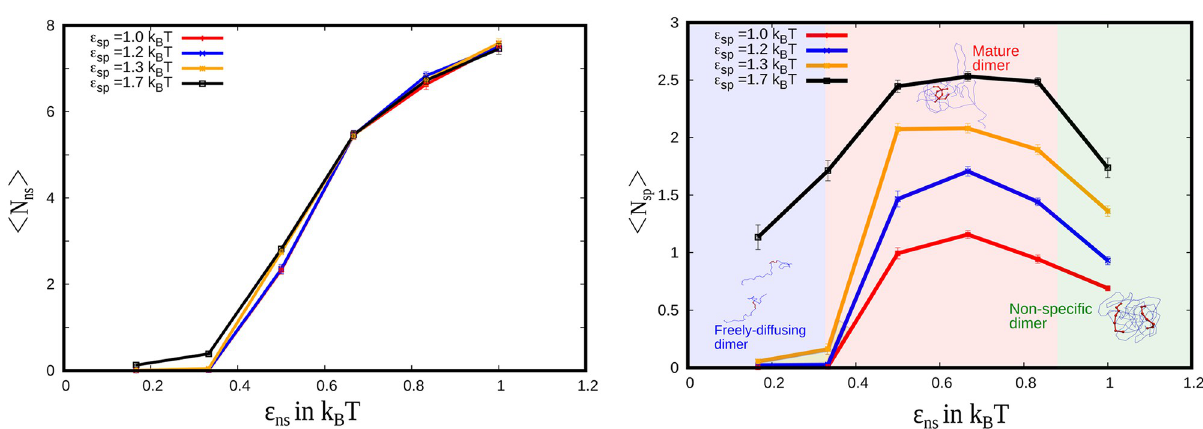
Fig 2. State of dimers for different non-specific interaction strengths. A) Average non-specific contacts per bead as a function of � ns for different value of � sp . B) Average specific contacts per bead as a function of � ns for different value of � sp . Both are averaged over 100 trajectories (colors are just a guide to